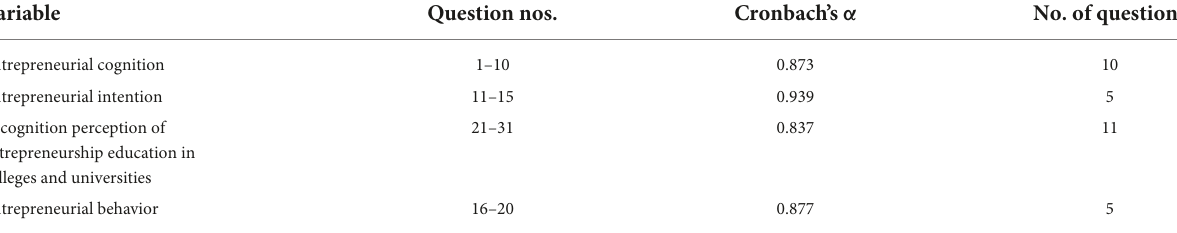
TABLE 2 Reliability results.